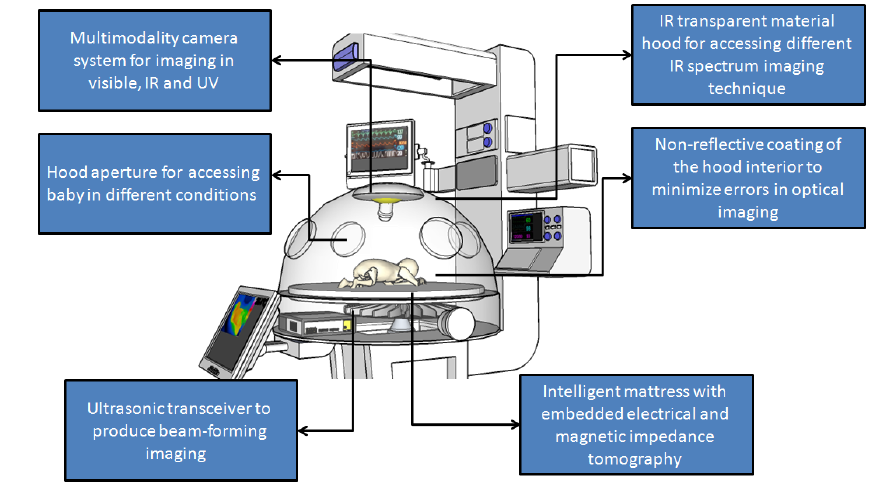
Figure 15. A schematic of neonatal incubator with multiple different embedded contactless imaging modalities for the early detection of various pathologies and neonatal